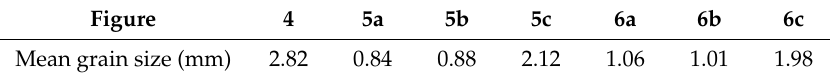
Figure 4. Macrostructure of the solidified Al ‐ 7 wt. %Si alloy in longitudinal section without external energy fields.